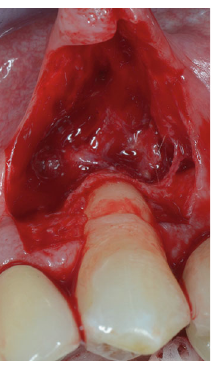
Figure 6: Two horizontal releasing incision are done: one deep, parallel to the bone crest and one, more extended, more super fi cial parallel to the oral mucosa (note the elasticity of the mucosa).